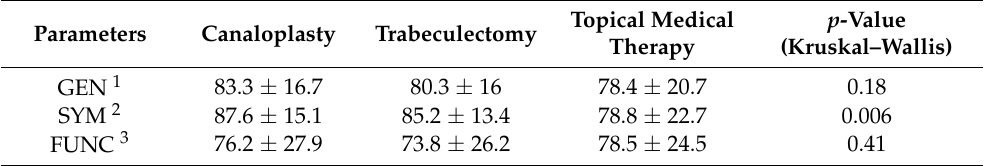
Table 3. Glaucoma Symptoms Scale (GSS) questionnaire: comparison between canaloplasty, tra- beculectomy and topical medical therapy through the Kruskal–Wallis test.